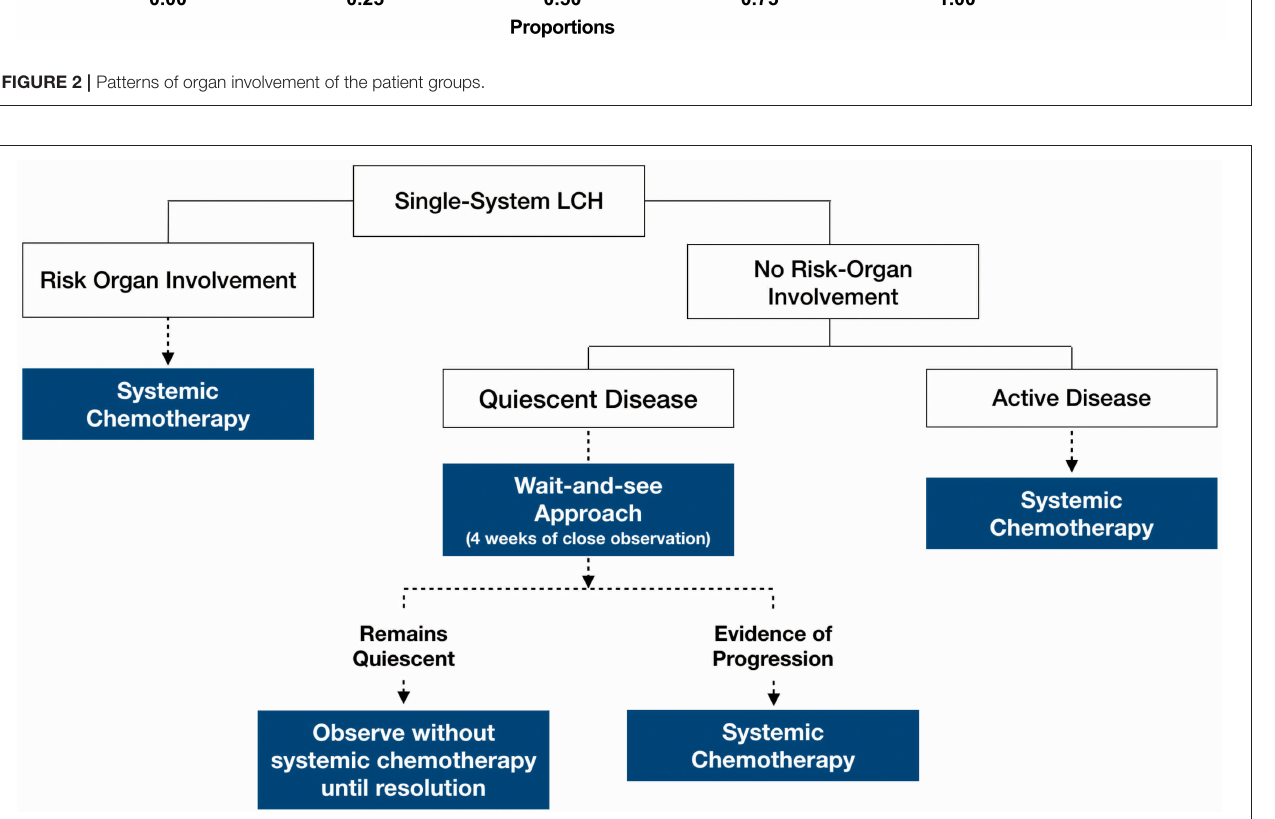
fracture, (4) incisional/excisional biopsies. None received intra- lesional